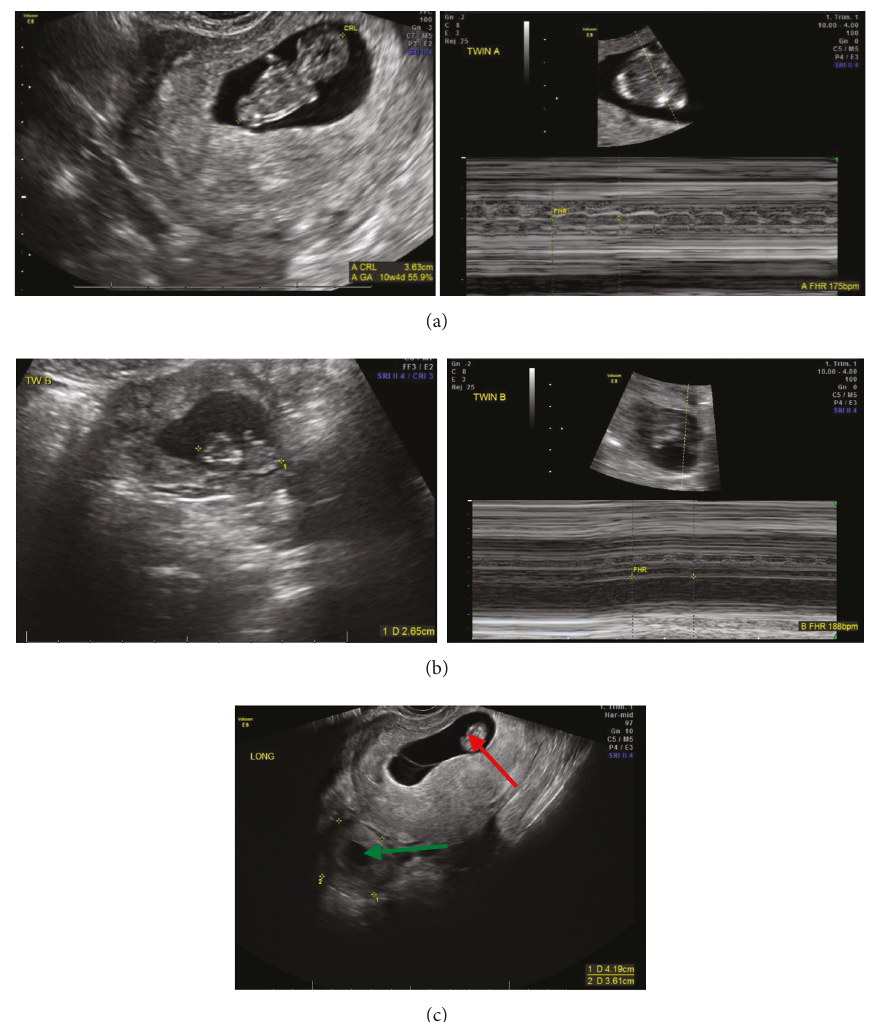
Figure 1: Official ultrasound showing positive FHR for Twin A, intrauterine pregnancy (IUP) ( a ); for Twin B, right tubal ectopic pregnancy (EP) ( b ); and presence of both Twin A [intrauterine pregnancy (IUP)] (red arrow) and Twin B [ectopic pregnancy (EP)] (green arrow) ( c ).